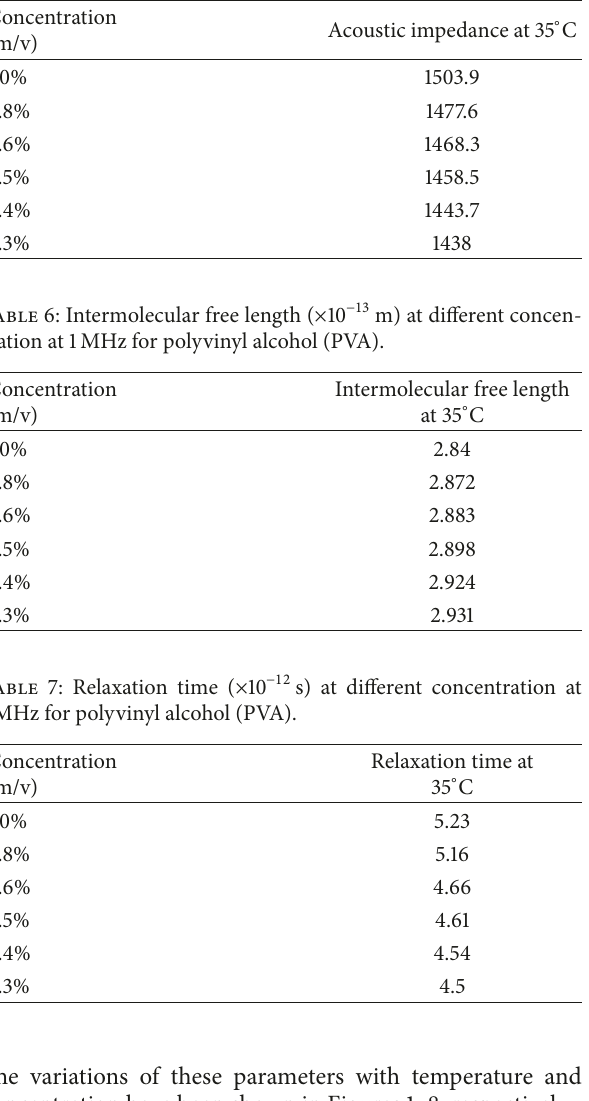
Table 5: Acoustic impedance ( × 10 3 kg m 2 s −1 ) at different concen- tration at 1MHz for polyvinyl alcohol (PVA).